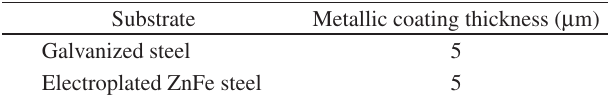
Table 1. Substrates used and their characteristics. Substrate